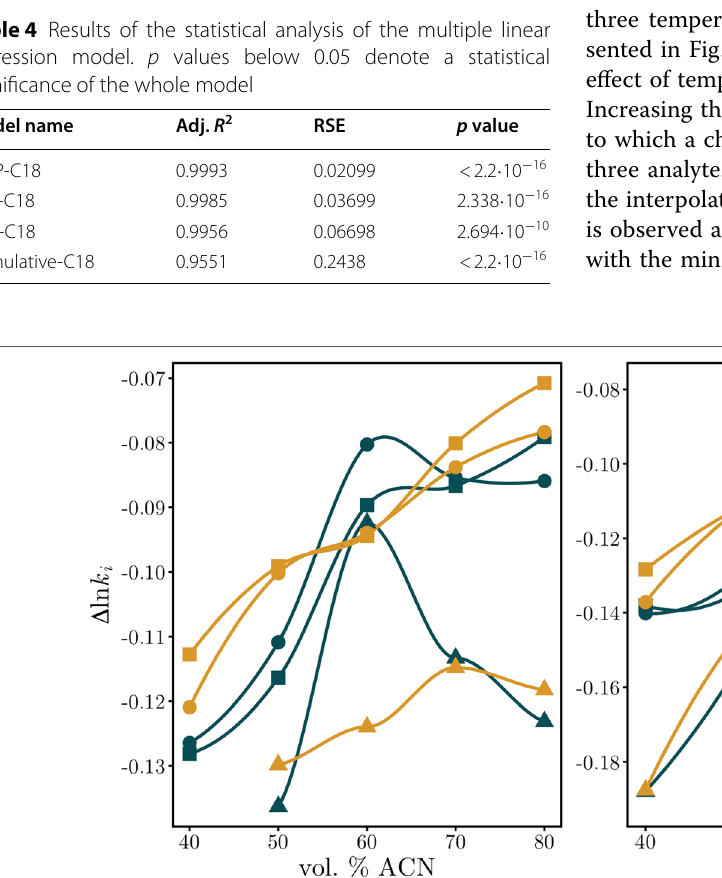
Fig. 4 The differences in the experimental retention data calculated at constant mobile phase compositions and three different temperatures on both investigated